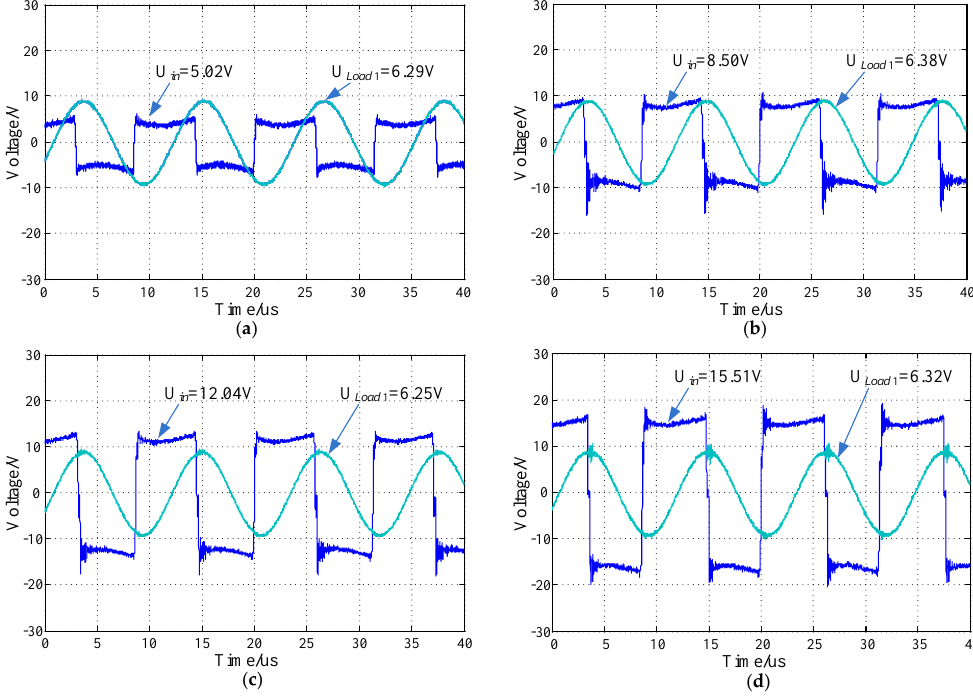
Figure 11. The voltage waveforms of power source and the voltage waveforms of loads: ( a ) one-load system; ( b ) two-load system; ( c ) three-load system; ( d ) four-load system. The efficiency stack graph of systems with different load numbers when systems are at a steady state is shown in Figure 12. The efficiency increases with the increased load number.